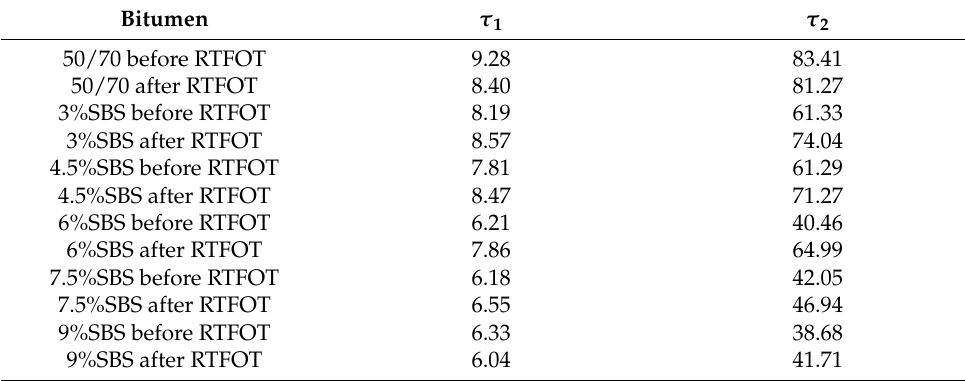
Table 9. Values of relaxation time (parameters η 1 , η 2